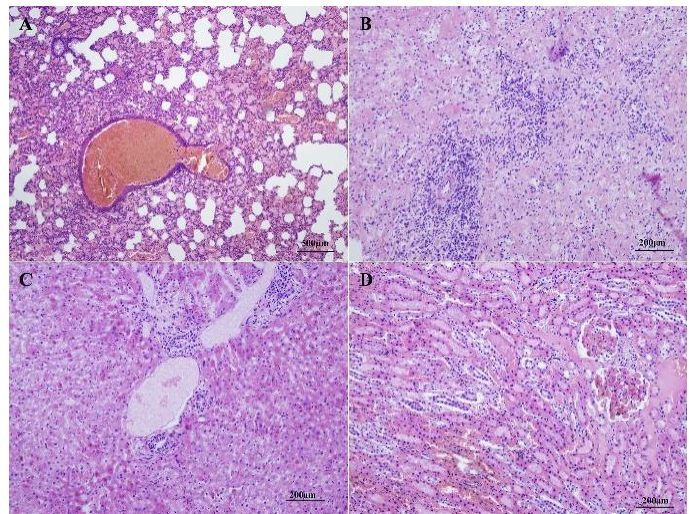
Figure 7. Histopathological changes in rabbits infected with the RHDV strain GS/YZ. Lung ( A ): moderate, diffuse congestion in the alveolar capillary and blood vessels, extensive hemosiderin deposition, and dilation of bronchioles. Liver ( B ): vacuolar degeneration of hepatocytes in the central zone of the lobule, karyopyknosis and karyolysis in some hepatocytes, and mild sinusoidal dilation and congestion. Spleen ( C ): disorganization of the splenic architecture, extensive necrosis and atrophy of the white pulp with severe lymphocyte depletion, and moderate hemorrhage in the parenchyma. Kidney ( D ): congestion of interstitial blood vessels, microthrombosis in the glomerular capillaries, and degeneration and karyopyknosis in numerous tubular epithelial cells [33,34]. Figure 8. Detection of RHDV VP60 signals in the livers of the rabbits inoculated with the tissue homogenates of the dead Alpine musk deer by immunohistochemistry. Incubation with the primary antibodies against VP60 ( A ); incubation without the primary antibody as the control ( B ). In addition, RHDV genes were detected in all liver samples of the infected rabbits by using RT- PCR methods. These results indicate that GS/YZ caused typical macro- and microscopic lesions in rabbits similar to that of other RHDVs. 4. Discussion The Alpine musk deer has been listed as an endangered animal species. Protecting them from fatal diseases has priority over other protective actions in China. The fatal disease that occurred in Xinglongshan National Natural Reserve has posed a severe threat to the Alpine musk deer population. The identification of potential causative agents of the disease is of great importance for